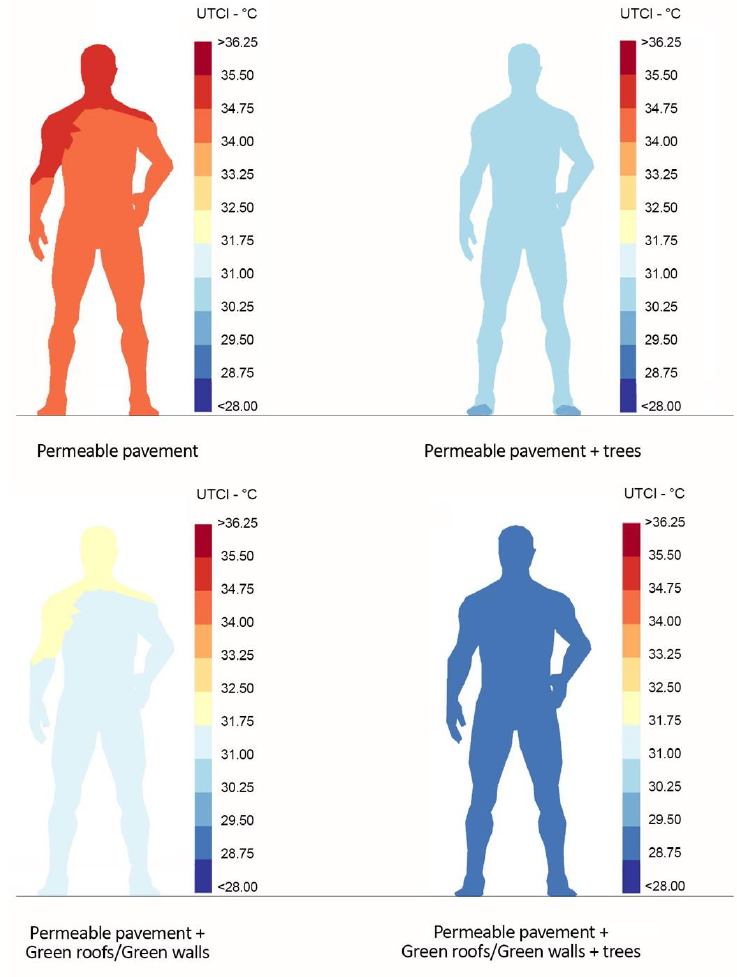
Figure 6. Scenario 2: permeable pavement.